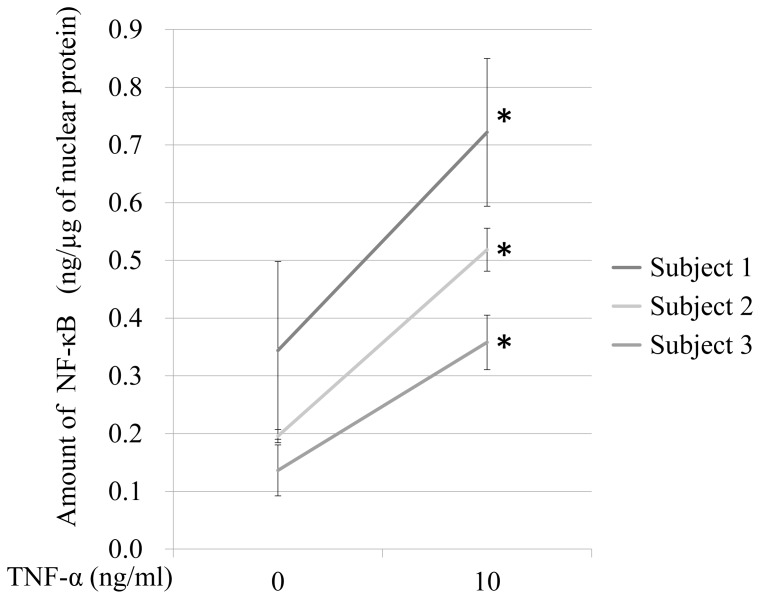
Quantitative results of the NF-κB activity in the nuclear extracts of human lymphocytes.Lymphocytes were isolated from three individuals (Subjects 1, 2 and 3) and treated with 10 ng/ml of TNF-α for 15 minutes. The NF-κB activity in the human lymphocytes was increased by TNF-α stimulation. Each bar represents the mean ± SEM of five measurements. *p<0.05.